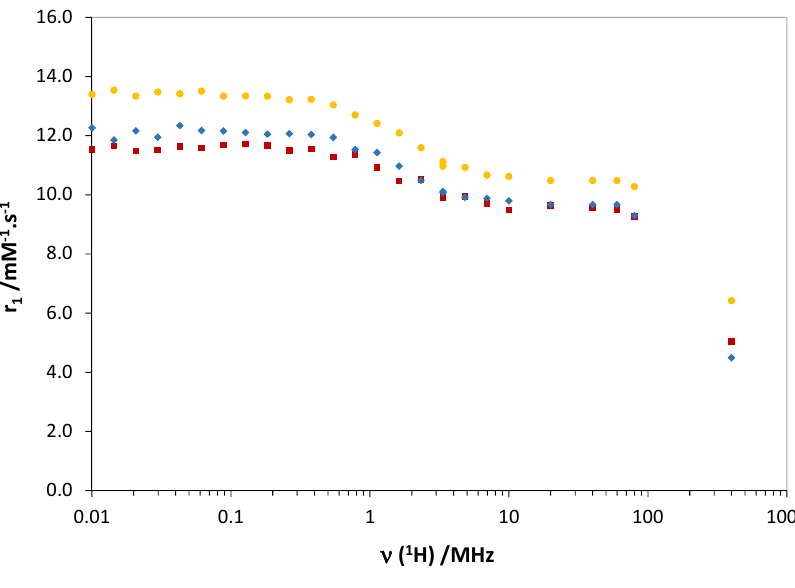
Figure 3. 1 H NMRD profiles of 1 ( ) 2 ( ), and 3 ( ) at 25 °C and pH = 7.0.